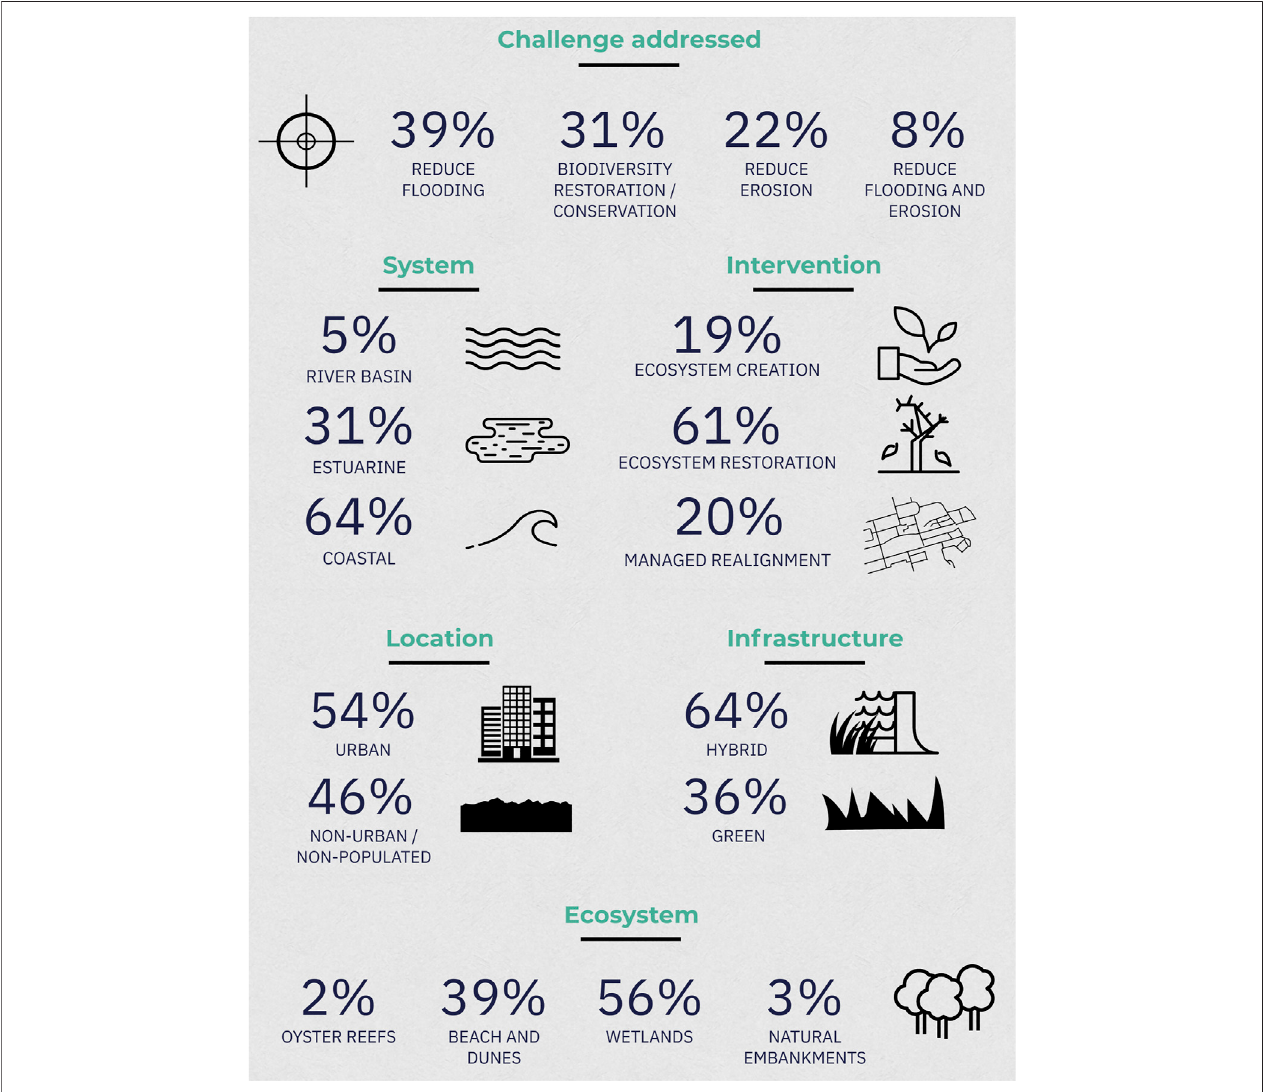
FIGURE 2 | Key characteristics of the review of NbS projects in coastal and estuarine areas in Europe (Infographic produced using Piktochart online tool - https:// piktochart.com/).